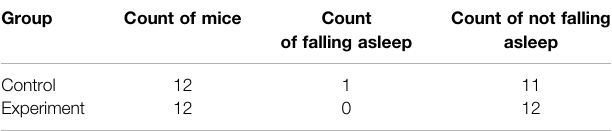
Figure 5B . Summarily, mice in the model group recorded signi fi cantly lower forelimb lift counts than those in the control group ( p < .05). Male mice in the model group had lower forelimb lift counts compared to those in the control group, albeit at no statistical signi fi cance ( p > .05). On the other hand, female mice in the model group recorded signi fi cantly lower forelimb lift counts than their counterparts in the control group ( p < .05).